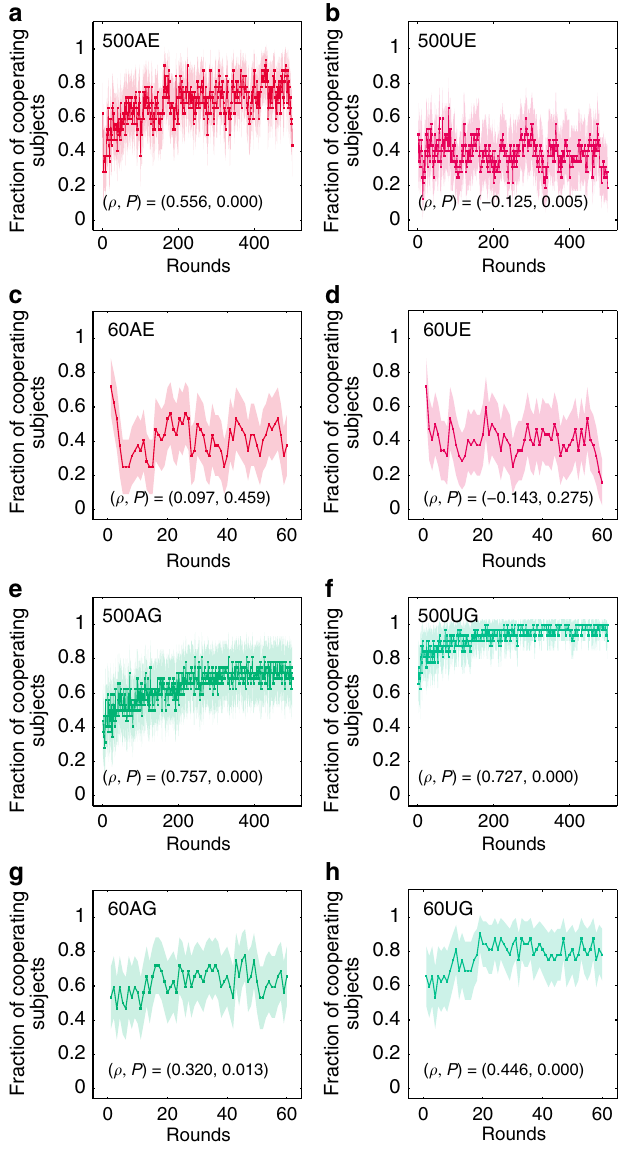
Figure 3 | Human cooperation rates over the course of the game. The graph shows the fraction of cooperating human subjects for each round for extortionate treatment ( a , b , c , d ) and generous treatment ( e , f , g , h ). Dots represent the average human cooperation rate at a particular round within a treatment, with the shaded areas depicting the 95% confidence interval. The (colour) line indicates the time trend. Significant rising trends of cooperation behavior appear in both 500AE ( a ) and 500AG ( e ) treatments. (( r , P ) in each subfigure indicates the Spearman’s rank correlation coefficient and the corresponding P value). Significant positive time trends in cooperation were also found in the 500UG ( f ), 60AG ( g ) and 60UG ( h ) treatments, while there was no significant time trend in the 60AE ( c ) and 60UE ( d ) treatments. There was a significantly negative time trend in cooperation in the 500UE ( b ) treatment. Supplementary Figure 4 also provides the smoothed average time trends. In addition, Supplementary Figs 5 and 6 provide the smoothed time trend of individual human